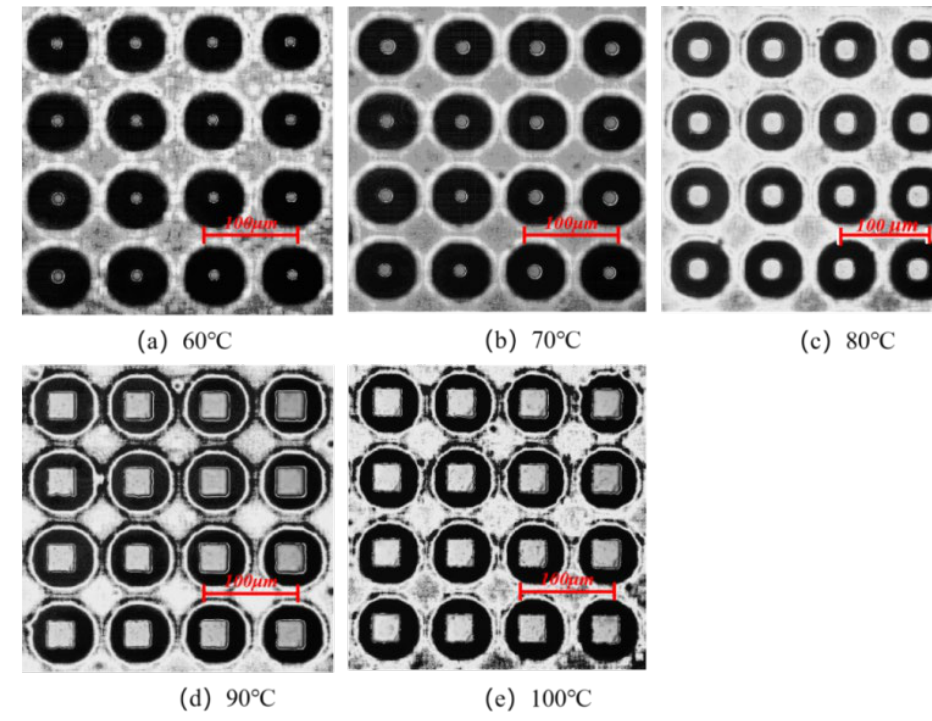
Figure 7. Microstructure replication morphologies at different mold temperatures.